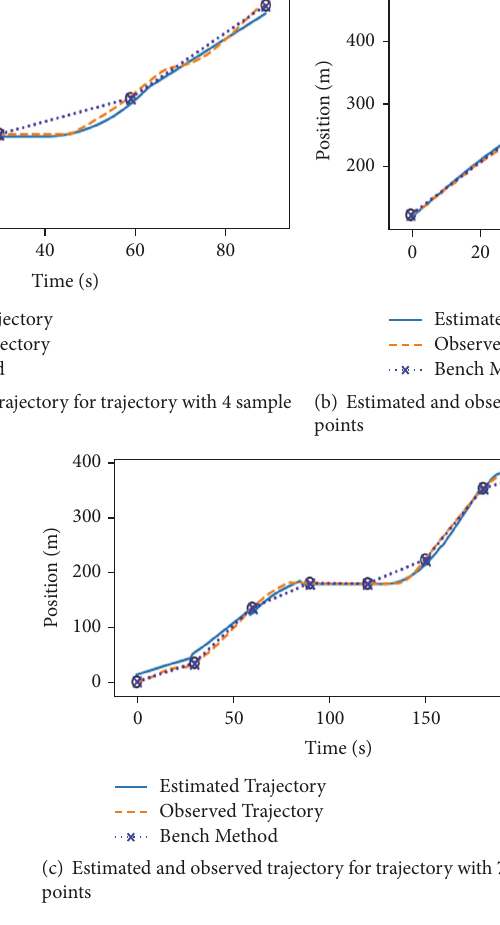
Figure 10: Comparison of estimated trajectory with the observed and linear method based trajectories.